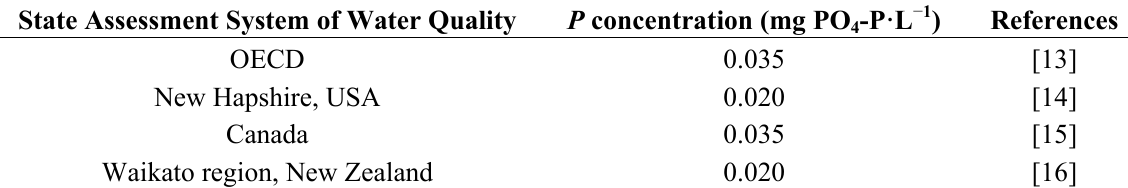
Table 1. The examples of P limit values of eutrophication